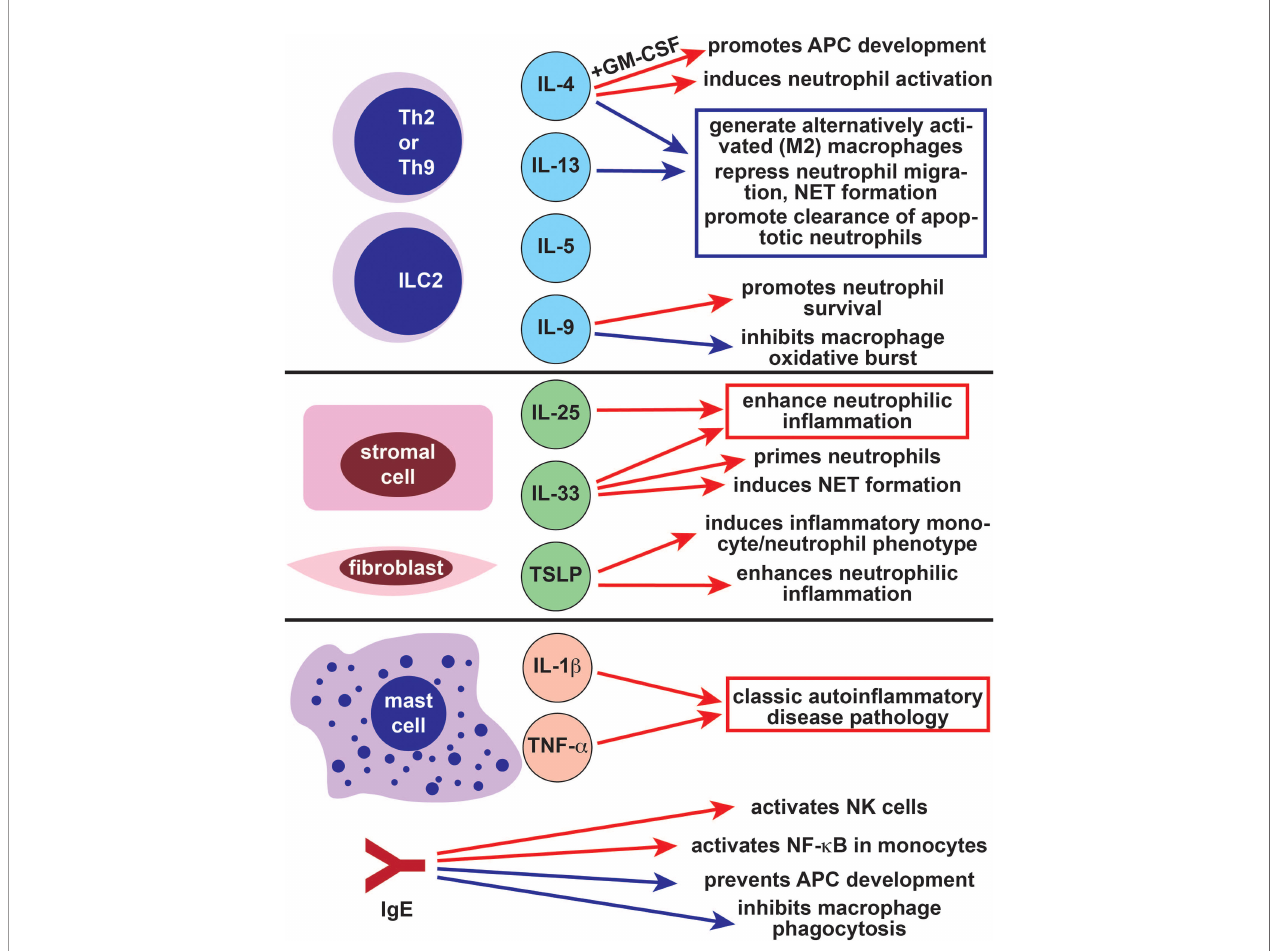
FIGURE 4 | The role of type 2 immune cells and cytokines in autoin fl ammatory cells and pathways. The Th2- and ILC2-derived cytokines IL-4 and IL-13 largely suppress autoin fl ammatory pathology by inducing the differentiation of anti-in fl ammatory M2 alternatively activated macrophages and repressing neutrophil migration (blue arrows). IL-4 also has some positive effects on autoin fl ammatory cells (red arrows), particularly in combination with GM-CSF. Like IL-4, the Th2/Th9/ILC2-derived cytokine IL-9 has both positive (red arrow) and negative (blue arrow) effects on autoin fl ammatory cells. The alarmins IL-25, IL-33, and TSLP promote autoin fl ammatory pathology through their effects on neutrophils and monocytes (red arrows). Mast cells also promote classic autoin fl ammatory pathology by producing IL-1 b and TNF- a . The allergy- associated immunoglobulin IgE can both promote (red arrows) and repress (blue arrows) autoin fl ammatory disease. Th2, T helper 2; ILC2, type 2 innate lymphoid cell, IL-, interleukin-; GM-CSF, granulocyte macrophage colony stimulating factor; NET, neutrophil extracellular trap; APC, antigen presenting cell; TSLP, thymic stromal lymphopoietin; TNF- a , tumor necrosis factor alpha; IgE, immunoglobulin E; NK, natural